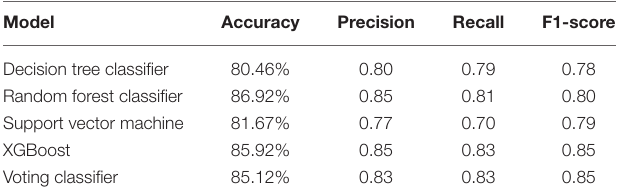
FIGURE 7 | Analysis on people affected by demented and non-demented group based on age. TABLE 4 | Performance comparison of different ML models.